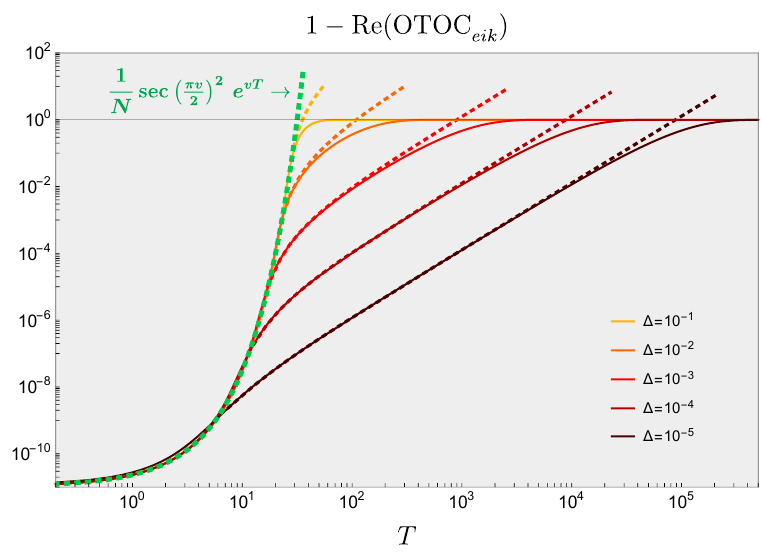
Figure 5 . Doubly logarithmic plot of the long-time OTOC (4.24) of the large q SYK model for N = 10 12 , v = 0 . 8 , and some values of ∆ . The dotted green line shows the approximately exponential time dependence ∼ e vT , which is applicable for all values of ∆ at early times. Other dotted lines approximate the subsequent ‘Ruelle’ regime up to O (∆ 2 ) , as shown in the second line of (C.2). The approximation in the first line of (C.2) is not shown as it would be indistinguishable from the solid lines in the Ruelle regime. One can verify from the plot that ‘scrambling’ ends after a time of order (cid:0) (cid:1) t scr ∼ 1 log N/q 2 and the time for the OTOC to deviate from 1 by an O (1) amount scales with v ∆ − 1 , cf.,